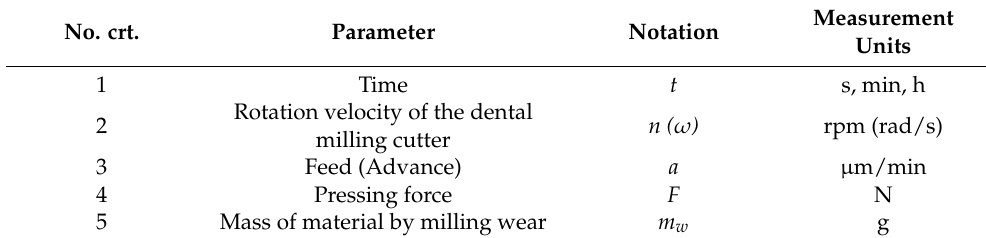
Table 1. Process parameters. No. crt.